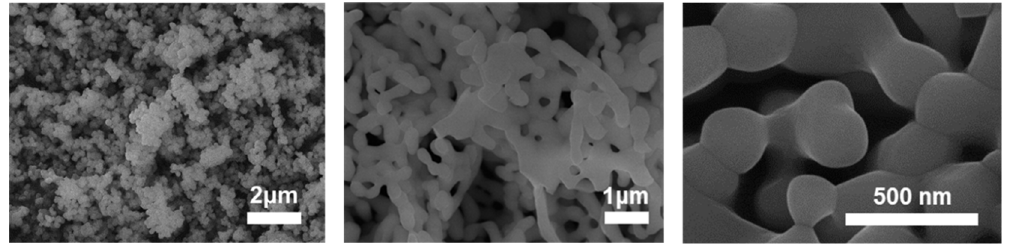
Figure 2. SEM images of LuAG:Ce 3+ nanophosphor prepared by sol ‐ gel combustion method.